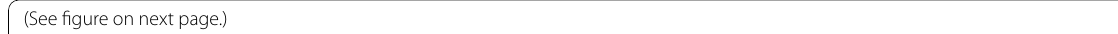
50 and l 0.4 ◦ . Horizontal bars indicate = =